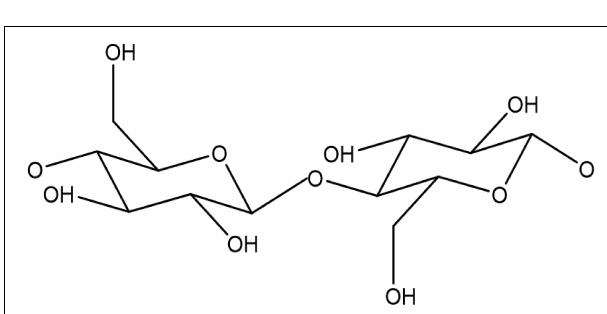
FIGURE 3 | Cellulose backbone consisting of D-glucose molecules linked in the β -1,4 position and rotated 180 degrees from each other.